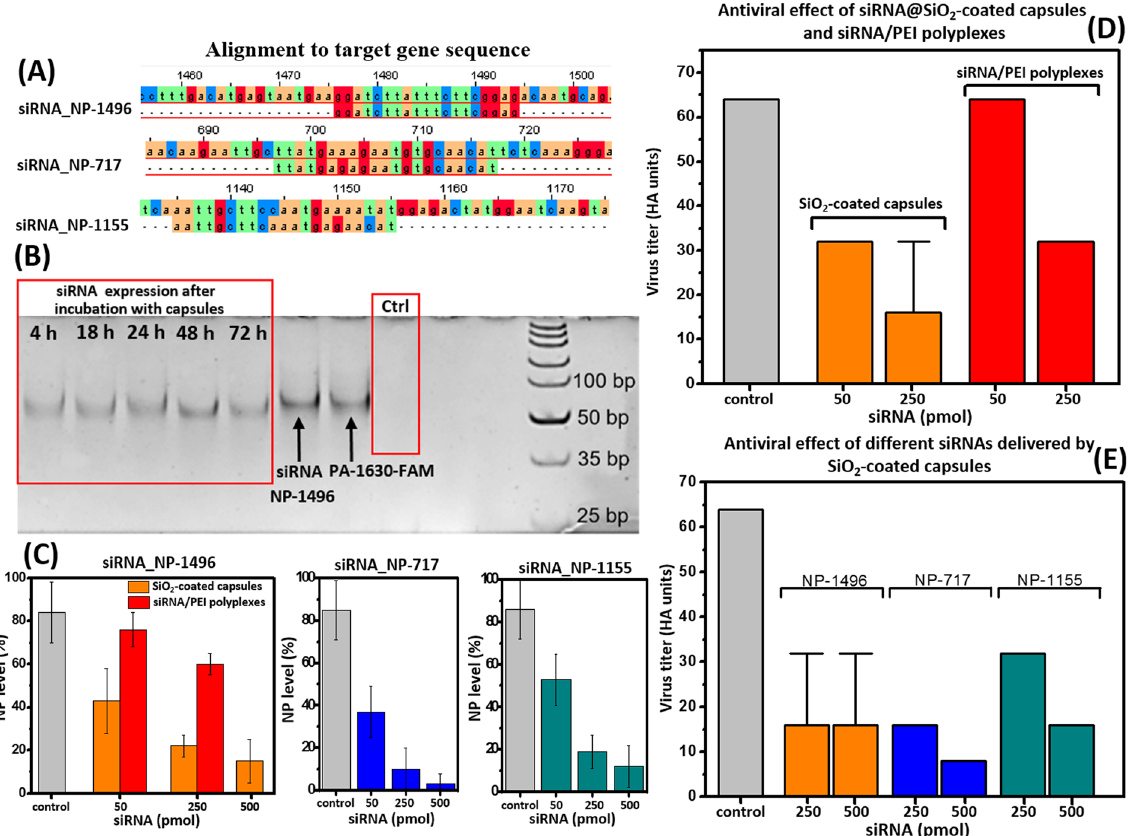
Figure 6. ( A ) Schematic diagrams showing the location of each siRNA in the viral genome. ( B ) Results of electrophoresis of the NP-1496 siRNA PCR products extracted from MDCK cells. ( C ) ELISA analysis showing the reduction of viral NP level in infected A549 cells treated with different anti-viral siRNAs in encapsulated form (50 pmol–1 capsule/cell; 250 pmol–5 capsules/cell; 500 pmol–10 capsules/cell). ( D ) Comparison of antiviral effect of NP-1496 siRNA delivered by siRNA/PEI polyplexes and SiO 2 -coated capsules (50 pmol–1 capsule/cell; 250 pmol–5 capsules/cell; 500 pmol–10 capsules/cell). ( E ) Inhibition of influenza virus production by different dose of siRNAs in encapsulated form. Viral titers was measured 72 h after infection in a hemagglutination assay. The data are presented as means ± standard deviation (SD) from three independent experiments. Note that some hemagglutination unit values were identical for the triplicate experiments, and so standard deviation values are